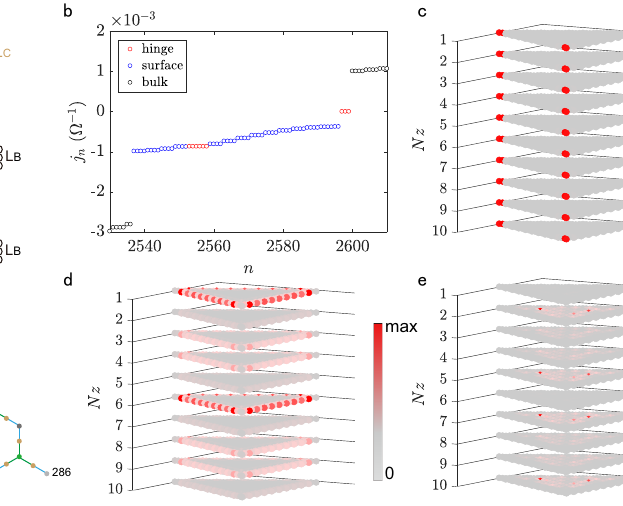
Laplacian. b Admittances for C A = C Z = C B /2=0.5 nF, L A =30 μ H, L B =7.5 μ H, L C =18 μ H, and L G =21.829 μ H. The red, blue, black symbols represent the hinge, surface, bulk states, respectively. Spatial distribution of the wave functions of the normal- ized hinge state ( j n =3.534×10 − 7 Ω − 1 ) ( c ), surface state ( j n = − 0.0003762 Ω − 1 ) ( d ), and bulk state ( j n =0.001042 Ω − 1 ) ( e